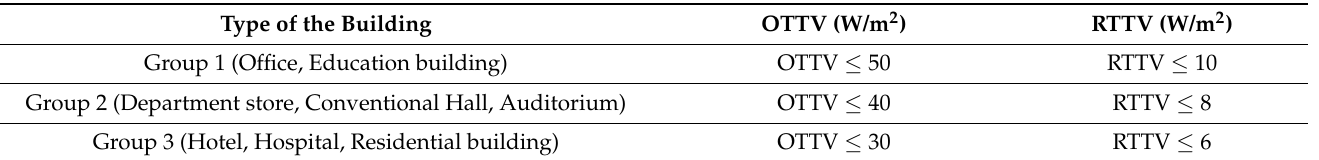
Table 2. Allowance overall thermal transfer value (OTTV) and roof thermal transfer value (RTTV) in building energy code. Type of the Building OTTV (W/m 2 ) RTTV (W/m 2 )